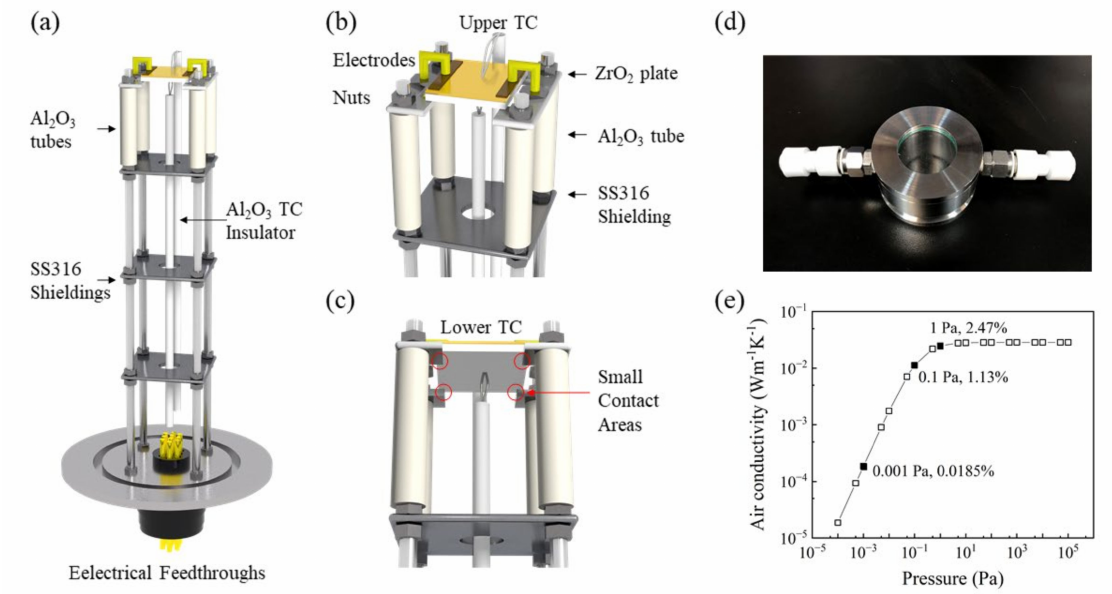
Figure 4. ( a – c ) A schematic of the sample holder used for EOC measurements, ( d ) a photograph of the water-cooled KBr flange, and ( e ) the relationship between the chamber pressure and the air